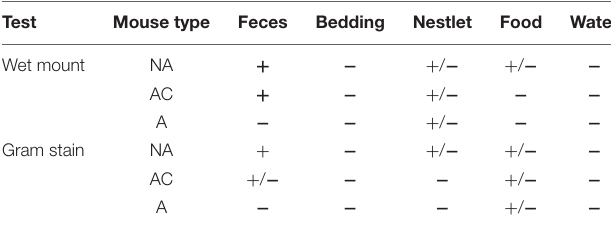
TABLE 1 | Blind readings of Isocage samples using wet mounts and Gram stain for different mouse